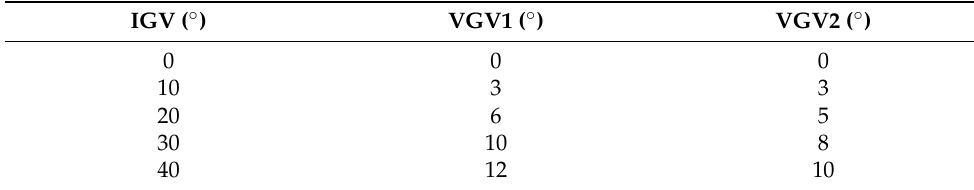
Table 1. Optimal joint turning angles of